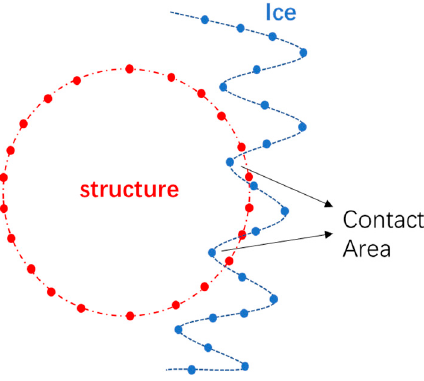
Figure 3. Geometrical discretization of ice–structure interaction.